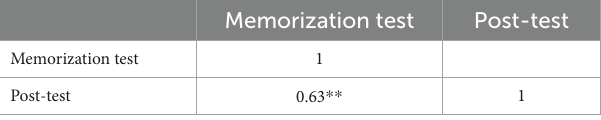
TABLE 2 Pearson correlation coefficients for text memorization test of seven model writings and